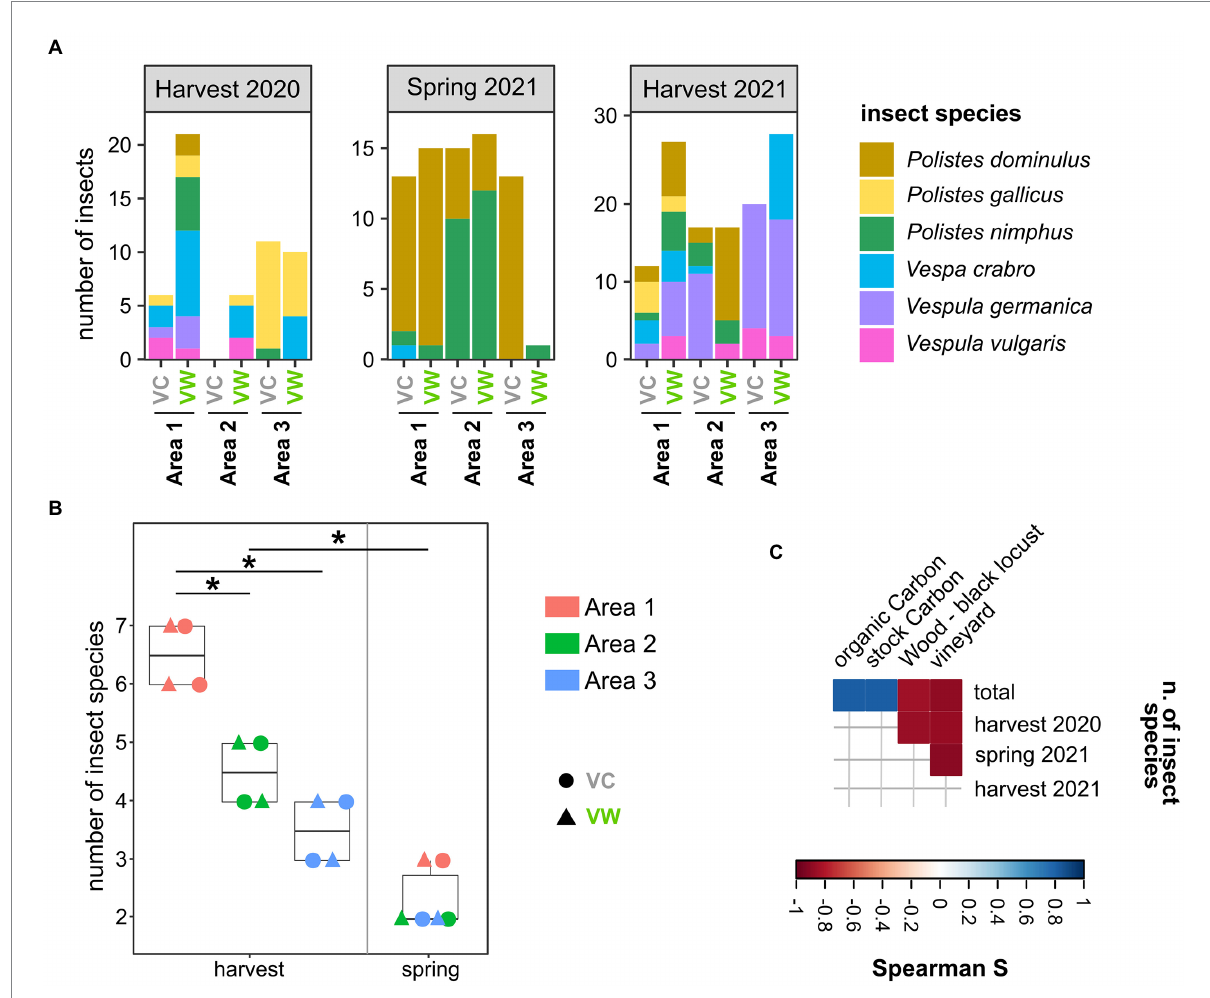
FIGURE 1 Sampled insects. (A) Representation of insect species among the sampled vineyards over the three sampling campaigns. (B) Alpha diversity (observed) calculated on insect species caught in the studied areas. Each point corresponds to a different sampling. *Wilcoxon–Mann–Whitney fdr < 0.05. (C) Spearman’s correlations between the number of insects caught in this study and the land cover, pedological, and topographical characteristics of the studied areas. Only significant correlations (fdr < 0.05) are shown. VC = Vineyards used as Controls; VW = Vineyards close to Wooded